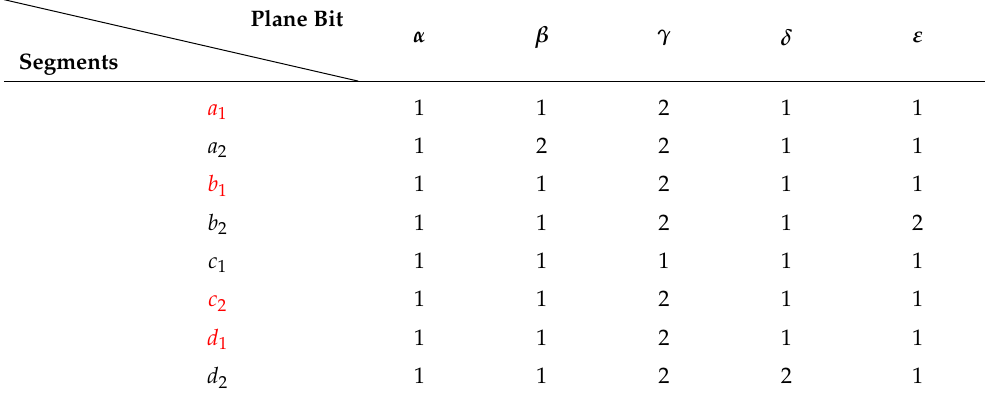
Table 2. Final coding table after extending the side whose code array contains 0.